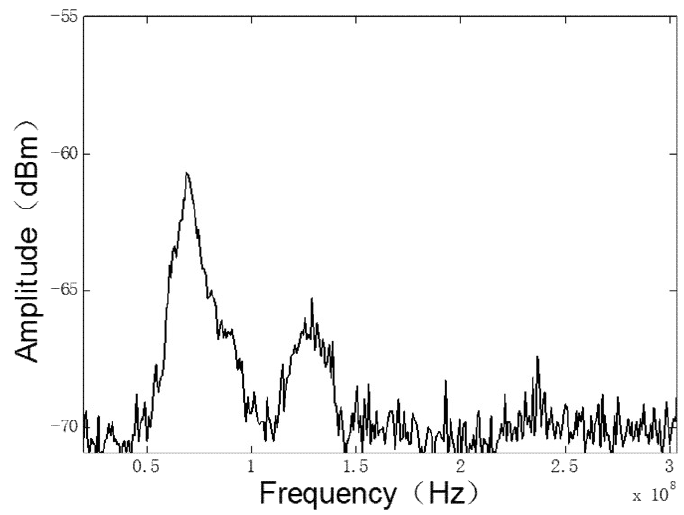
Figure 3. The spectrum of negative corona discharge EM radiation signal.